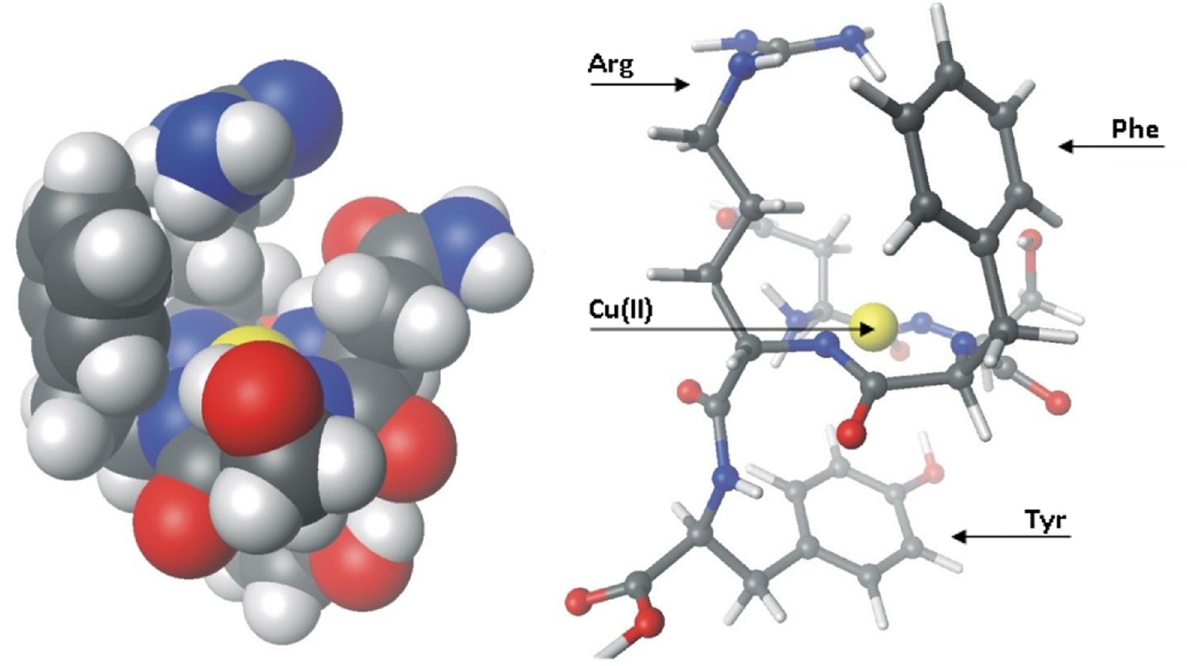
Fig 1. Calculated structures of the Cu(II)-NSFRY-NH 2 complex. Ball model – left side – and the stick model – on the right side.